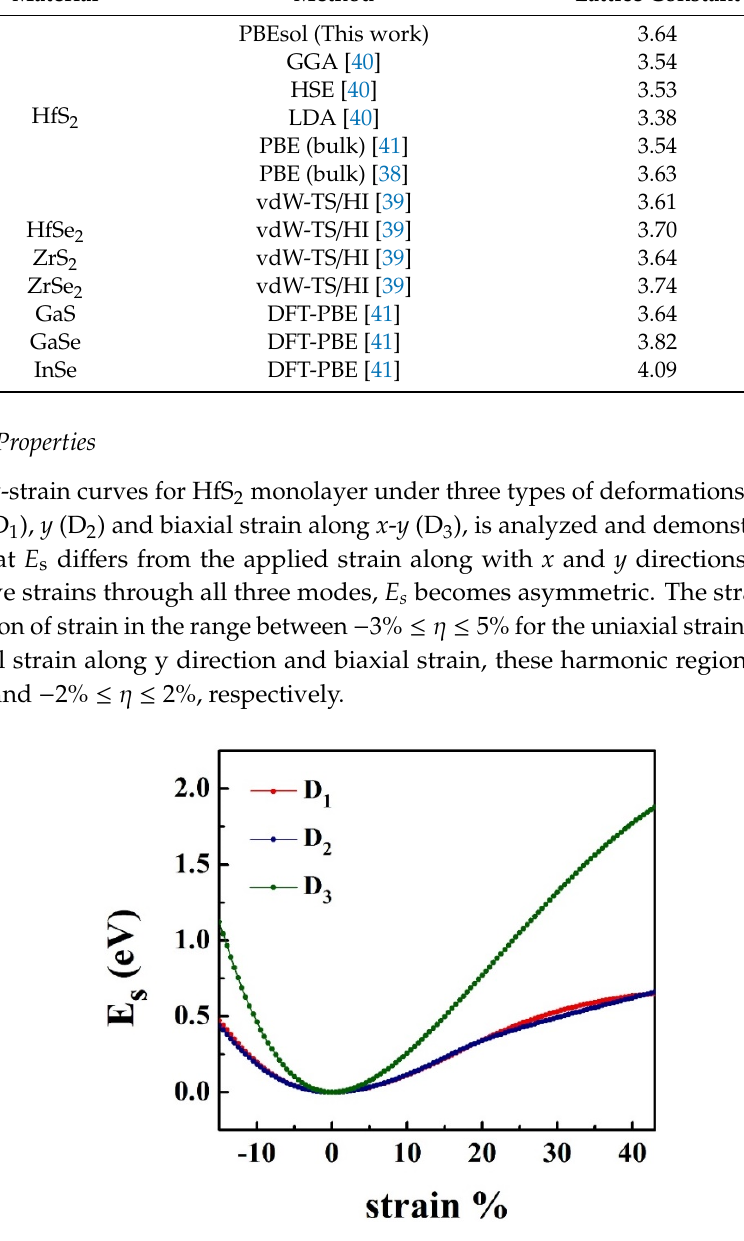
Table 1. Comparison of the lattice constants of 2D HfS 2 are calculated using different exchange-correlation functions along with the other reported values in the literature.